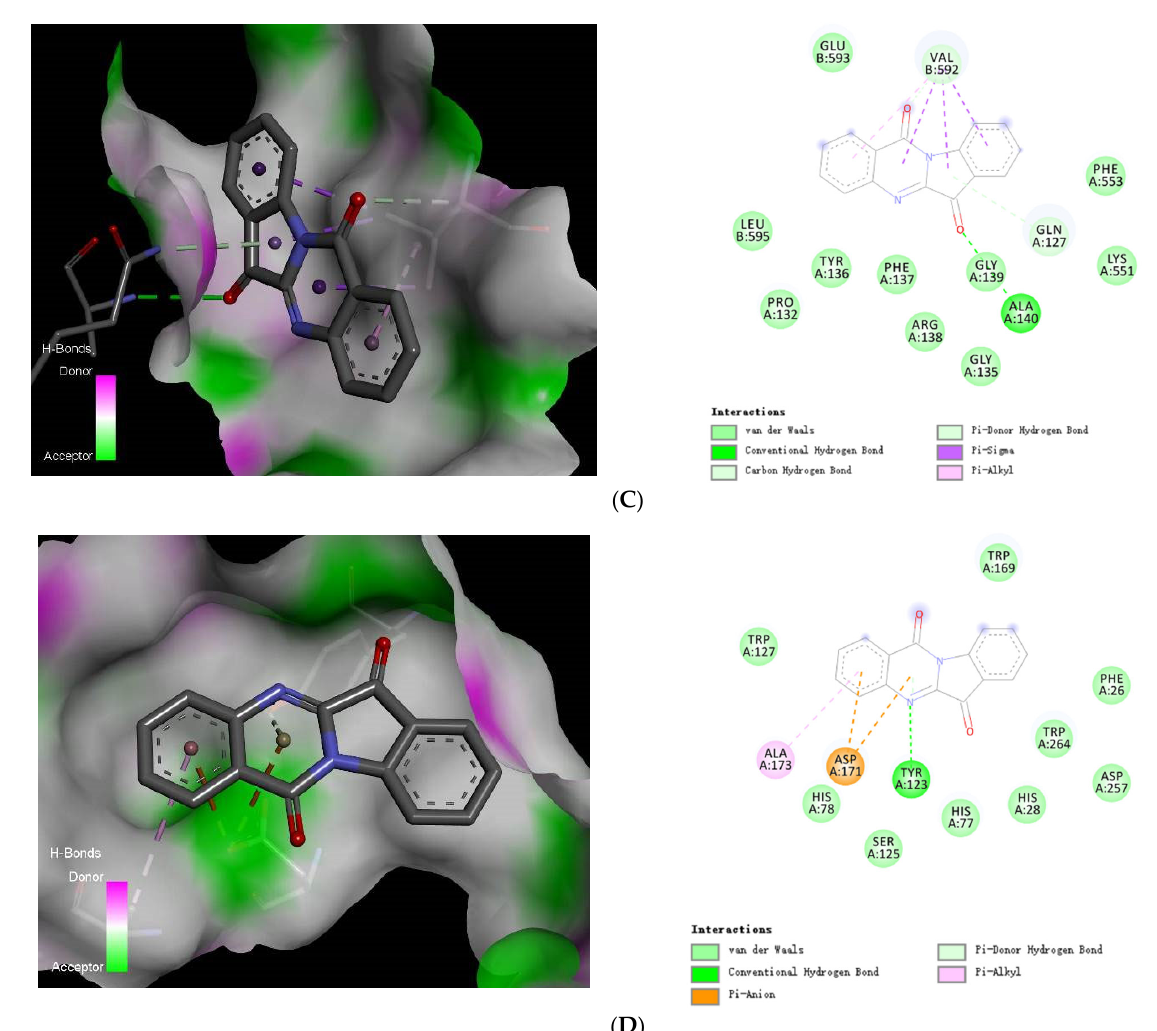
Figure 5. Docking conformations of Tryptanthrin with BgaA, StrH, SP_2141, and SP_2146. Diagrams representing 3D and 2D protein–ligand interactions of Tryptanthrin with the active site of BgaA (PDB code 4cu6) ( A ), StrH (PDB code 4azi) ( B ), SP_2141 (PDB code 5a6a) ( C ), and SP_2146 (PDB code 6org) ( D ).